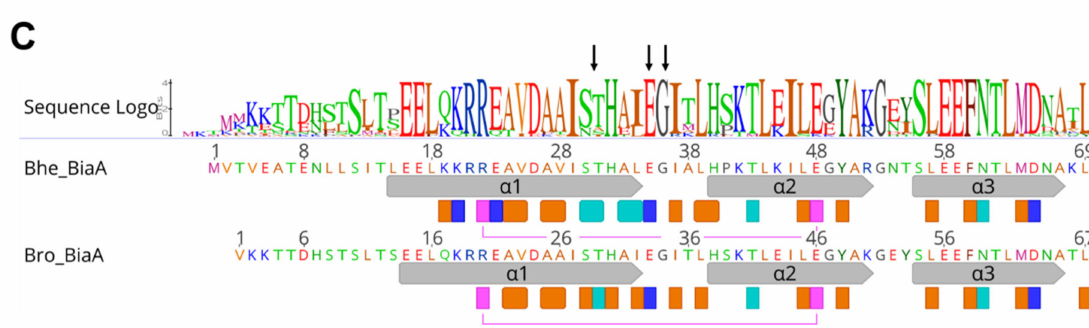
Figure 10. Structures of BepFIC/antitoxin complexes and antitoxin logo. ( A , B ) Crystal structures of Bhe _BepA/BiaA L4 (5NH2) and Bro _Bep1/BiaA L3 (5EU0); representation as in Figure 2, with interface residues shown in full. The insets show the view from the back to visualize the conserved intermolecular Asn–Asn interaction. The H-bonds between residues (cut-off 3.7 Å) are shown as yellow dashes and apolar interactions (cut-off 3.7 Å) are shown as grey dashes. ( C ) BiaA sequence logo derived from 23 Bartonella sequences (as defined in Figure 6 of [24], but without the divergent BiaA/2 from B. taylori) with annotated Bhe _BiaA and Bro _BiaA sequences underneath. Arrows above the logo indicate the residues of the inhibitory (S/T)xxxE(G/N) motif [1]. Secondary structure (grey arrows) and residues interacting with the toxin (as determined by PISA) are indicated by rectangles below the sequences (orange: apolar contact with at least 50% of the residue buried in the complex, light blue: H-bond, dark blue: salt-bridge). The magenta rectangles connected by a line indicate a conserved intra-molecular salt-bridge between α 1 and α